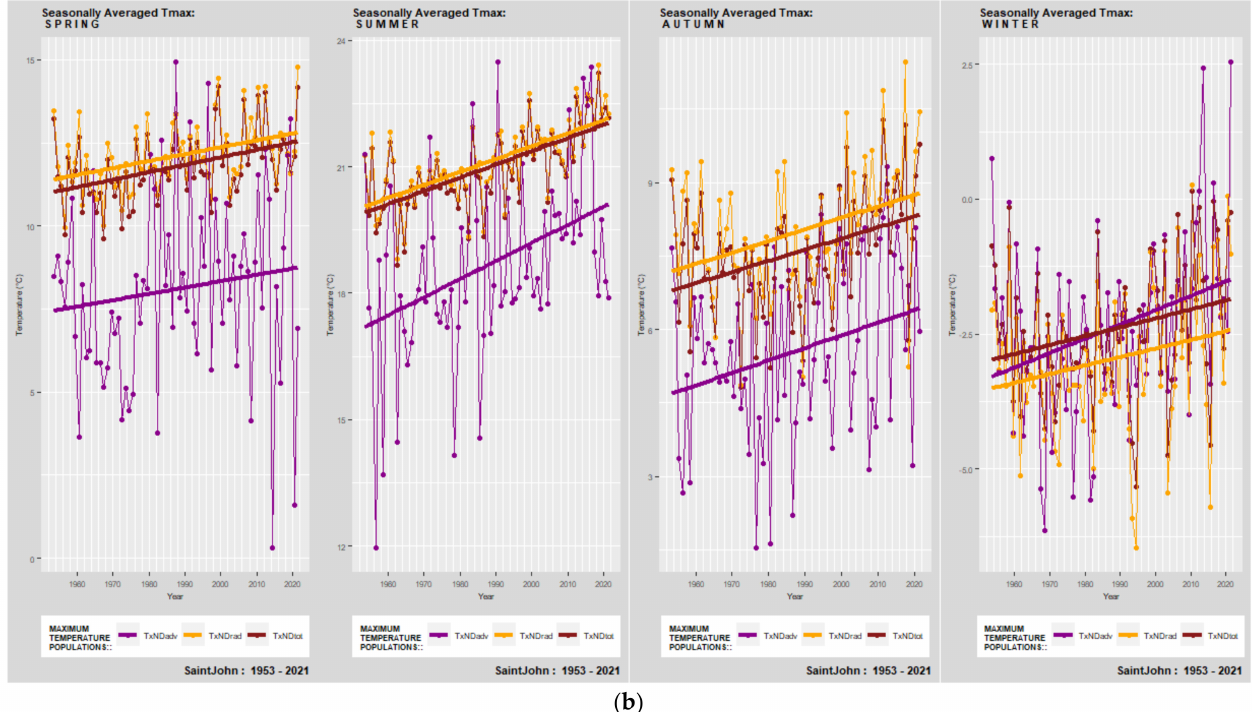
Figure 8. Atlantic Canada (ATL); Saint John (NB). Seasonally averaged daily temperature minima ( a ) and maxima ( b ), listed in order of Spring, Summer, Autumn, and Winter. ( a )—Total Temperature Minimum ( TT n ) (green), Radiative Temperature Minimum ( RT n ) (blue), and Advective Temperature Minimum ( TT n ) (pink); ( b )—Total Temperature Maximum ( TT x ) (brown), Radiative Temperature Maximum ( RT x ) (orange), and Advective Temperature Maximum ( TT x ) (purple).